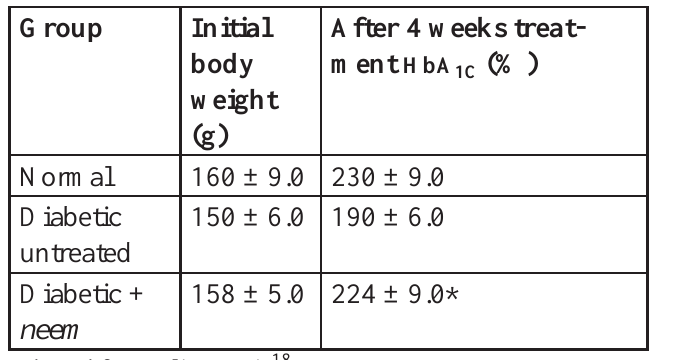
Table 5: Effect of water extract of Azadirachta indica on the body weight of rats. * p < 0.05 when compared with untreated diabetic